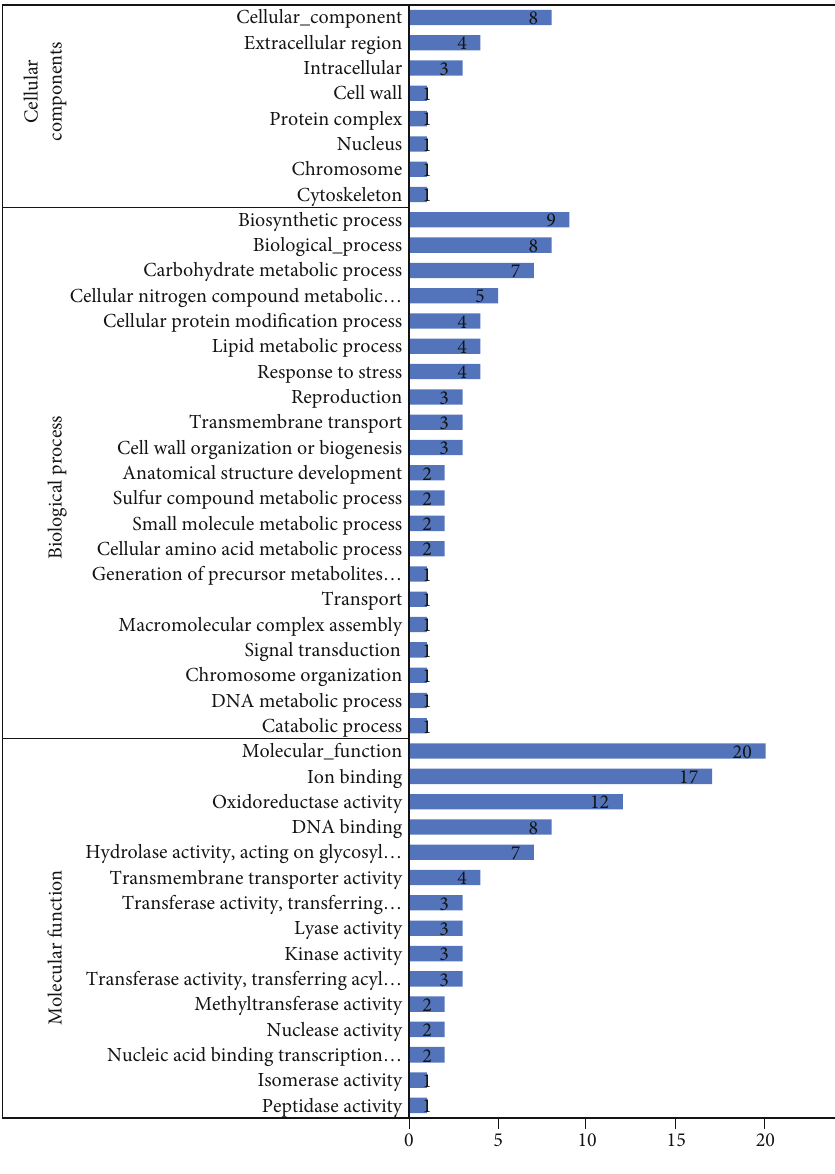
Figure 7: Downregulated GO terms identi fi ed in C. tetragonoloba under drought